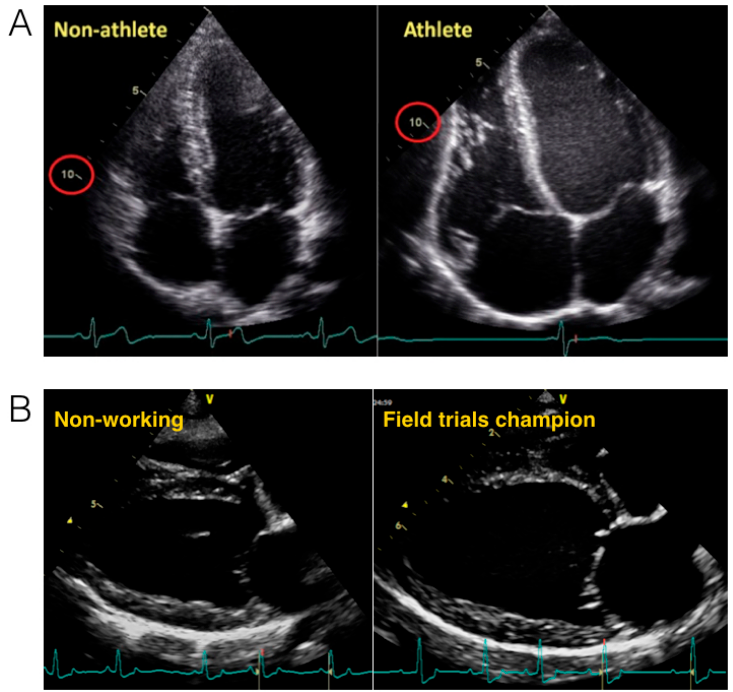
Figure 2. ( A ) Morphological changes in an athlete’s heart compared with a non-athlete’s heart. The normal heart of a 24-year-old librarian ( left ) is compared with that of a 23-year-old professional cyclist ( right ). Note the difference in scale such that the non-athlete’s ventricle is ~10 cm in length (circled in red), whereas the 10-cm mark reaches only halfway along the ventricle of the athlete. Note that all cardiac chambers are enlarged and that increases in wall thickness are relative to dilation. Taken with permission from La Gerche et al. [4]; ( B ) Morphological changes in a working dog’s (English Springer Spaniel) heart. The non-working dog (66 months old, 19 kg) ( left ) is compared with that of a Field trials champion (58 months old, 15.3 kg) ( right ). End diastolic volume in the non-working dog is 47 mL and 58 mL in the field trials champion.